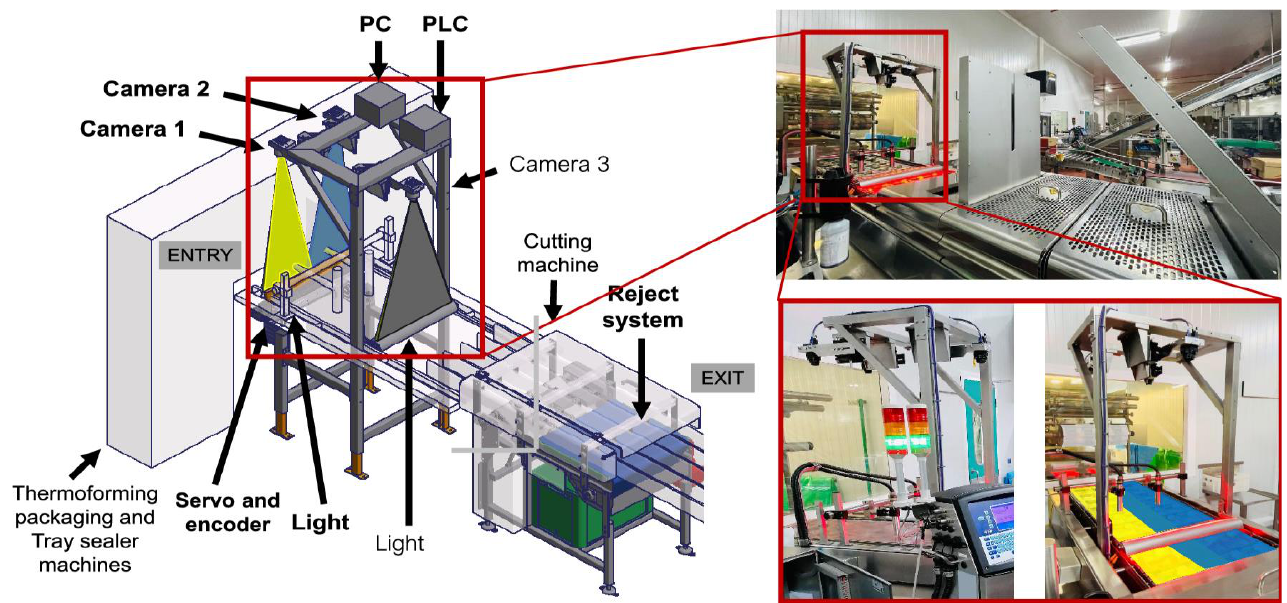
Figure 5. An illustration of the major elements of the suggested computer vision system, with views of the genuine scenario (bold). A servo and an encoder attached to a programmable logic controller (PLC) regulate the speed at which the food packages move, the position of the items, and the timing at which the reject system must be activated. The cameras are positioned between the tray sealer and the cutting equipment. Images for the sealing test are acquired by triggering monochrome line scan cameras 1 and 2 at various exposure periods. Images for the serigraphy and traceability tests are captured using camera 3. Then, after the photographs have been acquired, the reject system is processed to determine how to move forward. Reproduced from ref. [39] with permission from Springer Nature, 2021.